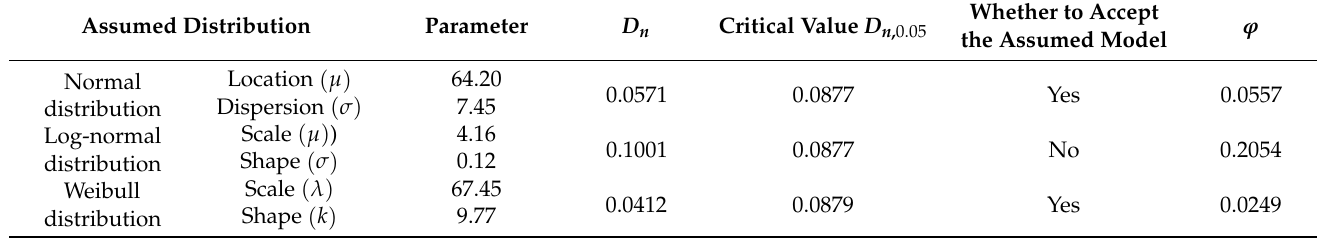
Table 5. K–S Test Result and Probabilistic Distribution of the Compressive Strength of the Lamina.